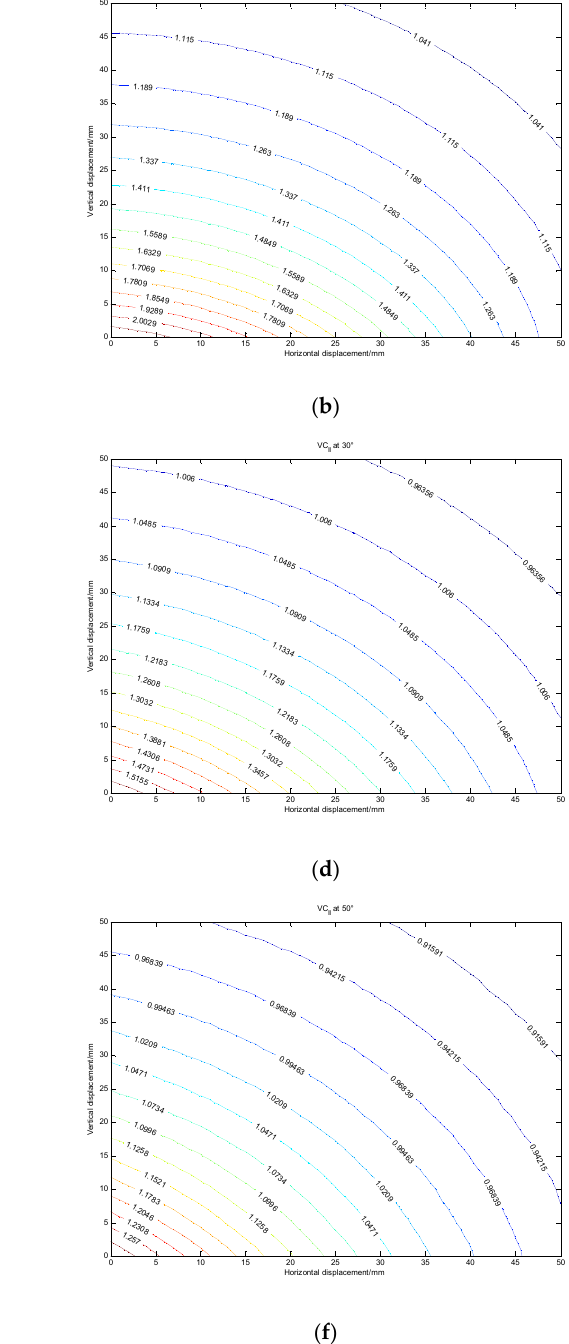
Figure 8. Double mutual inductance voltage contours at different inter-axis angles. ( a ) VC I at 10°; ( b ) VC II at 10°; ( c ) VC I at 30°; ( d ) VC II at 30°; ( e ) VC I at 50°; ( f ) VC II at 50°. It can be found from Figure 8 that the value of type I or type II mutual inductance voltage measured at a certain position will correspond to multiple different positions in the contour. The relative displacement between adjacent sensing units at the current time cannot be accurately judged only by one voltage contour of type I or type II. Therefore, the double mutual inductance voltage contour method is proposed in this paper. By virtue of the different self-inductance coefficients of the air-core coil and magnetic core coil, two mutual inductance voltage contours with different variation trends can be obtained